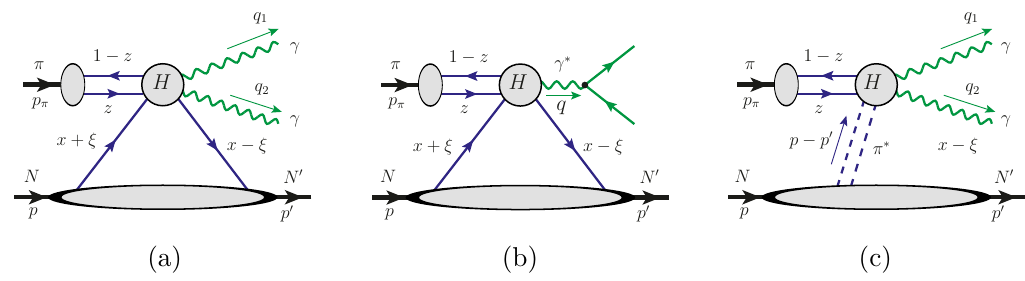
Figure 2. Exclusive massive photon-pair (a) and lepton-pair (b) production in pion-nucleon colli- sion, and (c) the photon-pair productions when | t | ≡ | ( p − p 0 ) 2 | → 0 .